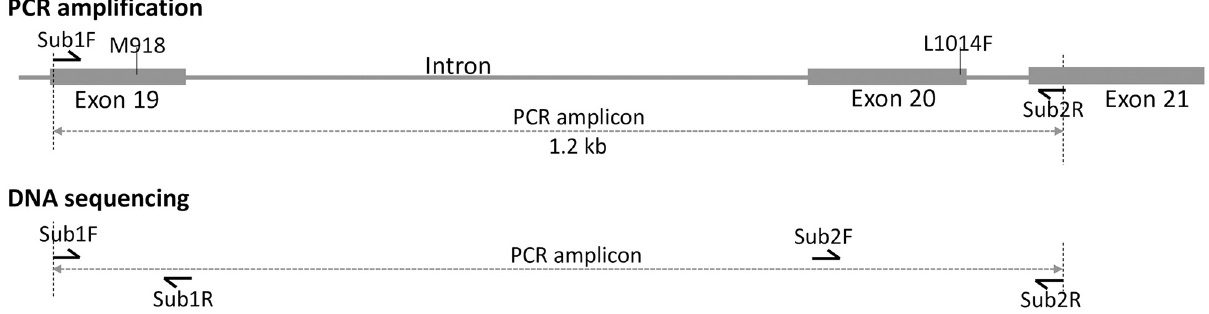
Fig 2. Schematic presentation of the location of primers (represented by harpoons) used for PCR amplification of partial VGSC (IIS4-S6) and sequencing. Exon numbering is based on the VectorBase (https://vectorbase.org) sequence of the voltage-gated sodium channel of An . epiroticus (Gene ID: AEPI015231; retrieved: 15 Sept